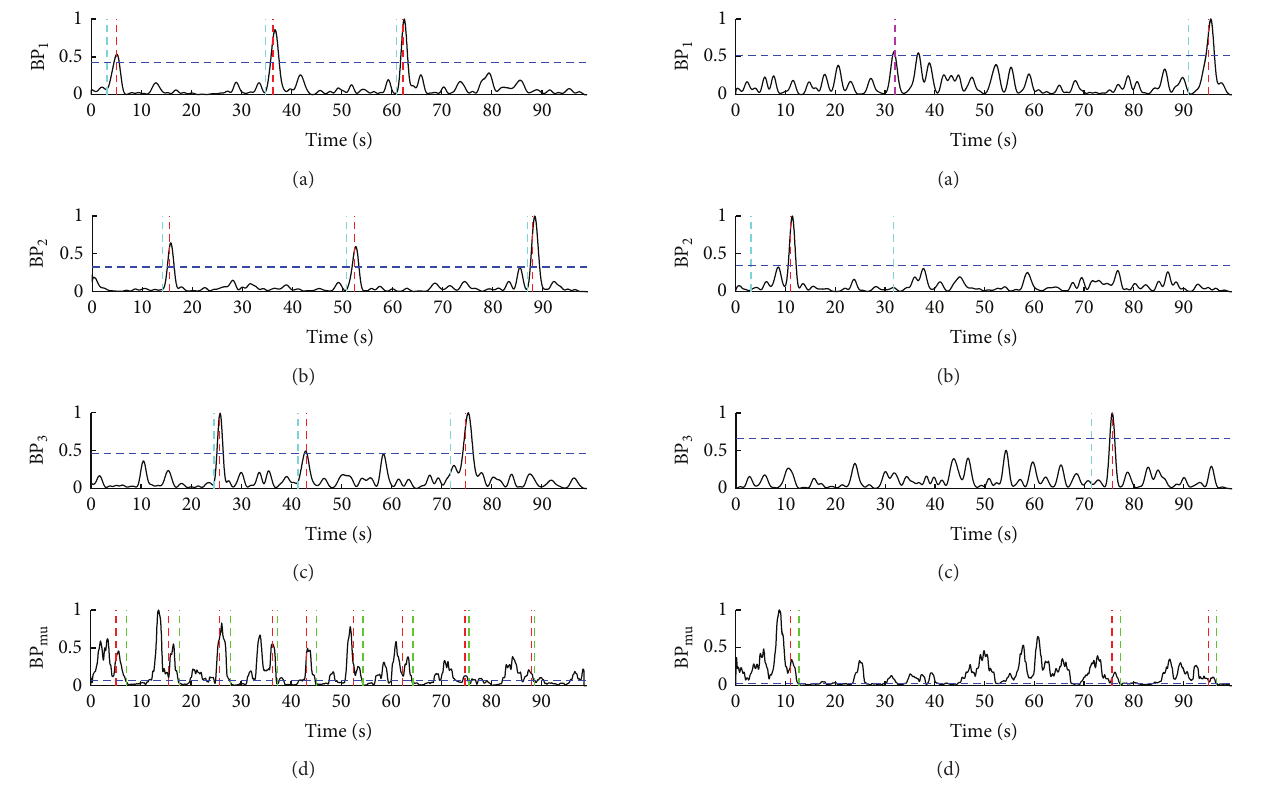
Figure 4: Normalized band-powers BP 1 , BP 2 , BP 3 , and BP mu from (a) to (d). Nine successful trials (TP), three per each LED, for subject S2 during the representative 100-second interval are shown. Turquoise vertical dotted lines in (a), (b), and (c) point to the time instants of visual focuses on LED 1 , LED 2 , and LED 3 , respectively, while red vertical dotted lines refer to the correct detections of SSVEP 1 , SSVEP 2 , and SSVEP 3 , respectively. Red lines in (d) mark all the correct SSVEP detections (TP ssvep ), that is, cues for MI. Blue horizontal dotted lines in (a), (b), (c), and (d) present the corresponding thresholds TH 1 , TH 2 , TH 3 , and TH erd , respectively. Green vertcial dotted lines mark the correct ERD detections (TP erd ).